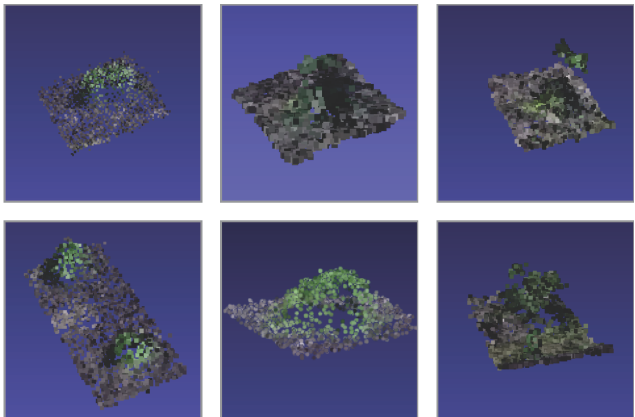
Figure 9. Sample of Bushes in The